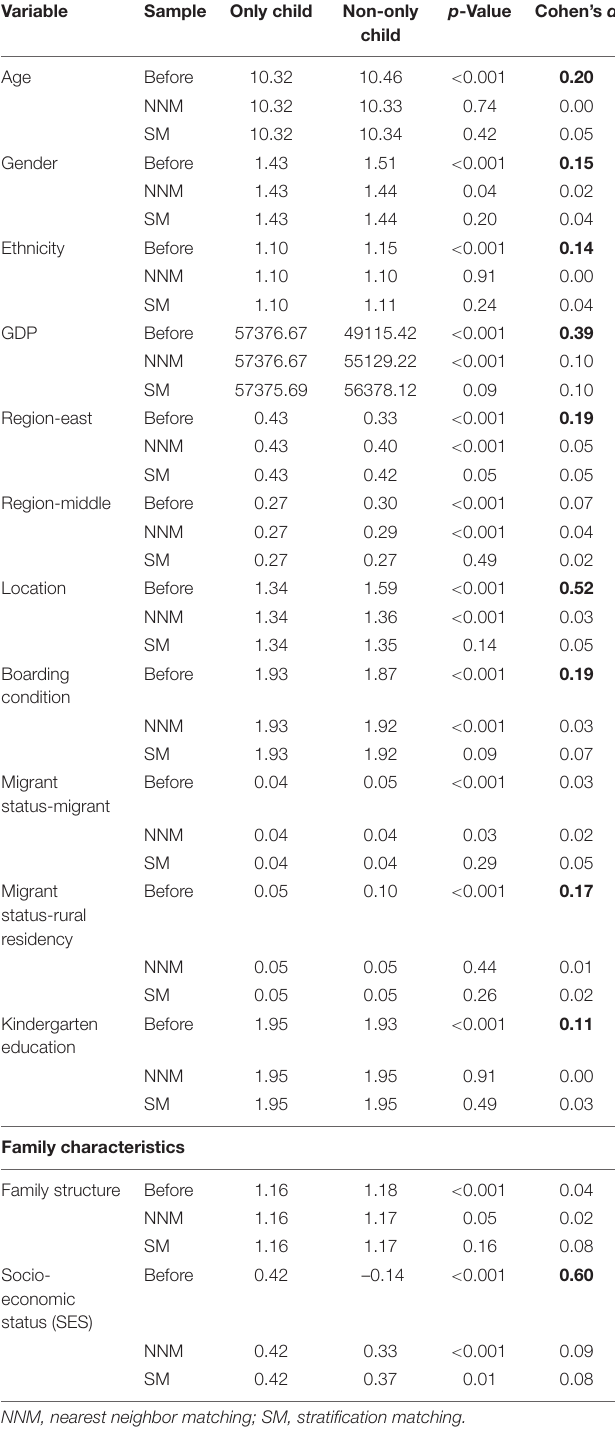
Outcome Parameter variables